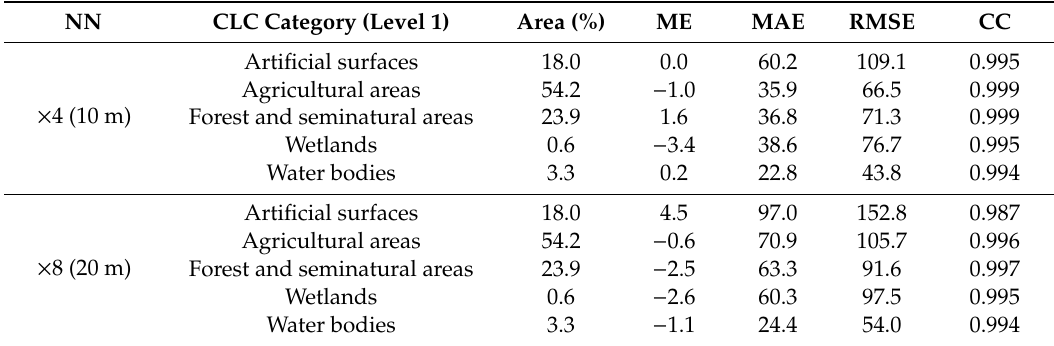
Table 6. Measured quality of the two super-resolution neural networks (NNs), from 10 to 2.5 m ( × 4) and from 20 to 2.5 m ( × 8), by main land cover (Corine Land Cover 2018) of the two Belgian S2 tiles (BeS and BeN together) (Figure 3). ME, mean error; MAE, mean absolute error; RMSE, root mean square error; CC, cross